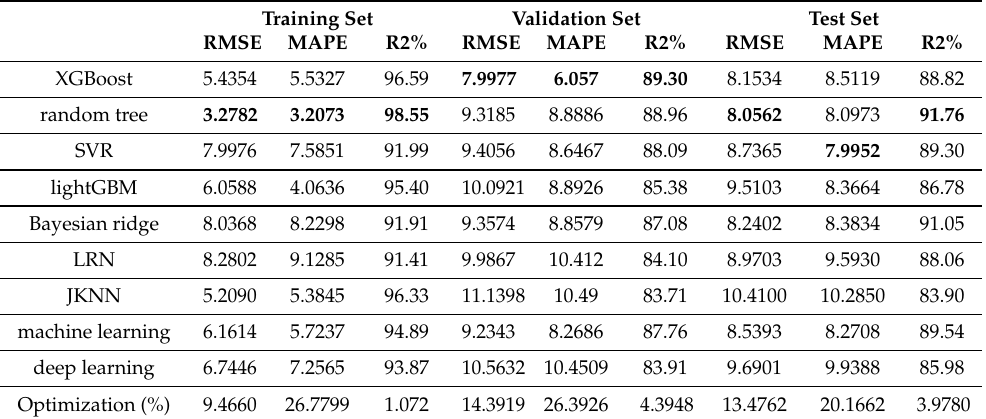
Table 2. Comparative prediction effects of different methods in the training set, test set, and validation set.